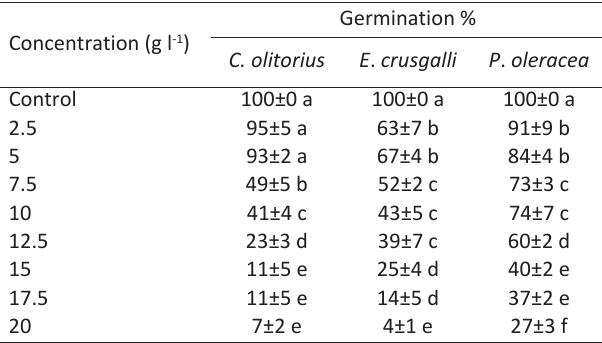
Table 2 - Effect of aqueous celery extract on shoot and root lengths of three weed species